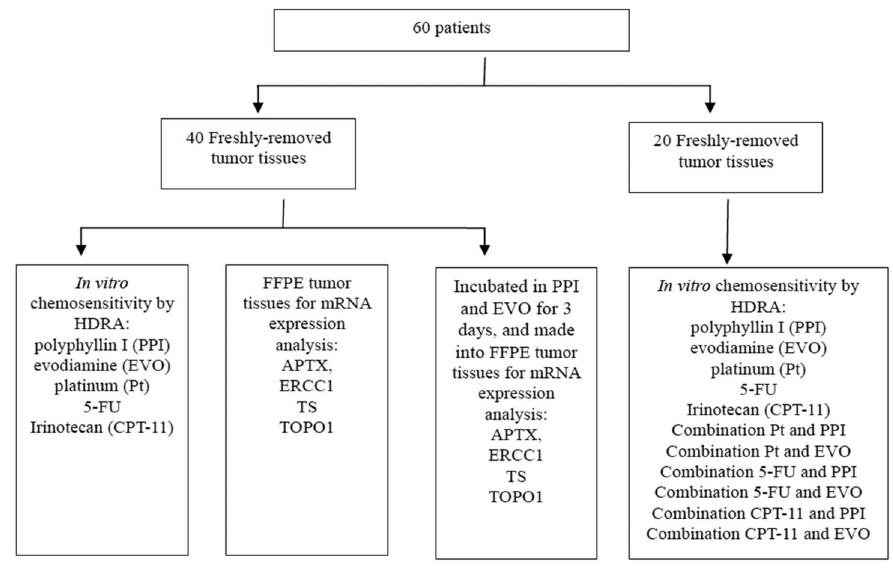
Figure 2. Flow chart showing patient disposition and experiments performed.